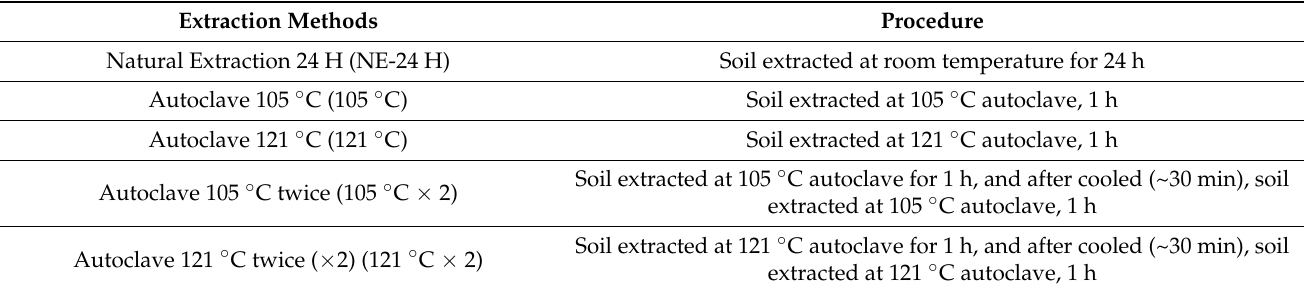
Table 7. Soil extraction